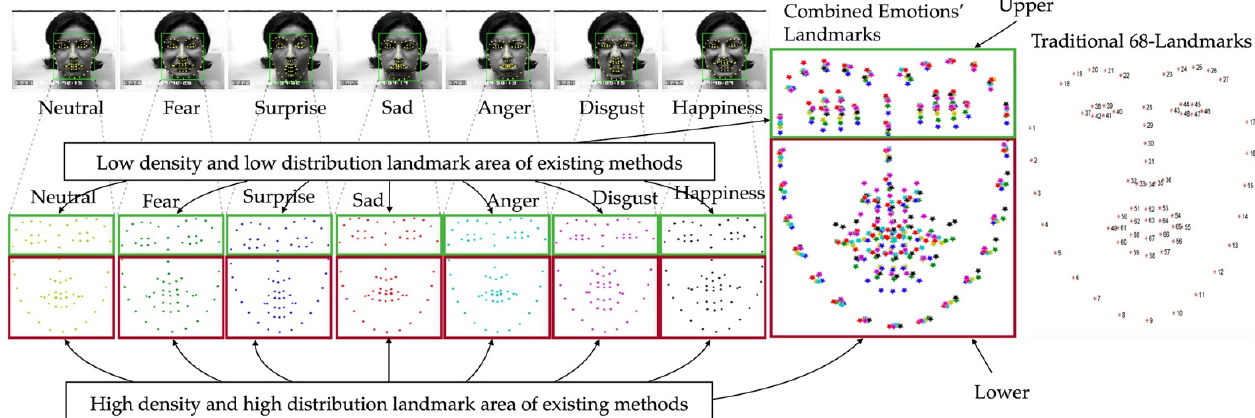
Figure 2. Traditional landmarks.